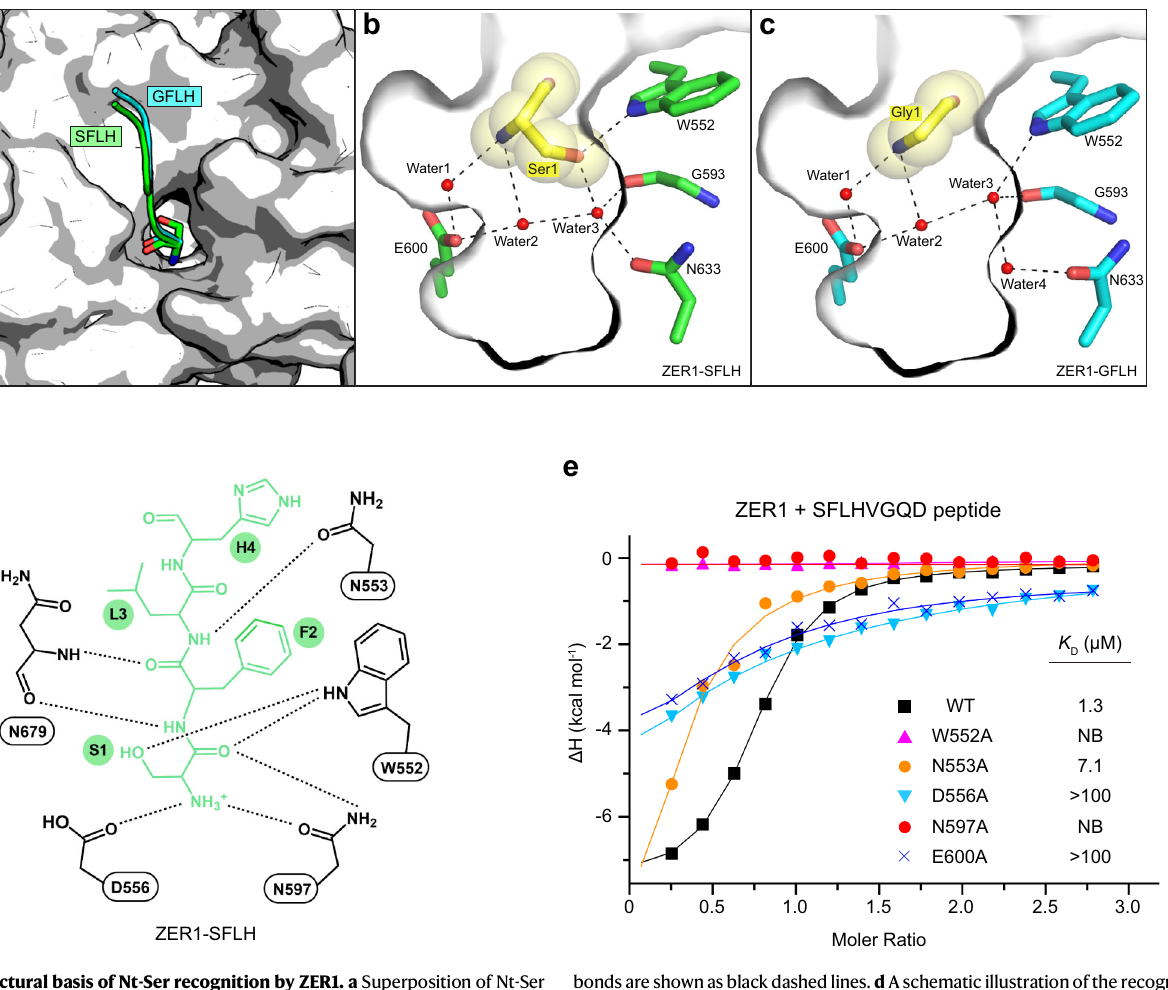
bondsareshownasblackdashedlines. d Aschematicillustrationoftherecognition of SFLH peptide by ZER1. e ITC fi tting curves of wild-type (WT) and mutant ZER1 (residues 469 – 766) titrated with SFLHVGQD peptide. The corresponding mutant proteins and binding af fi nities are indicated. NB, no detectable